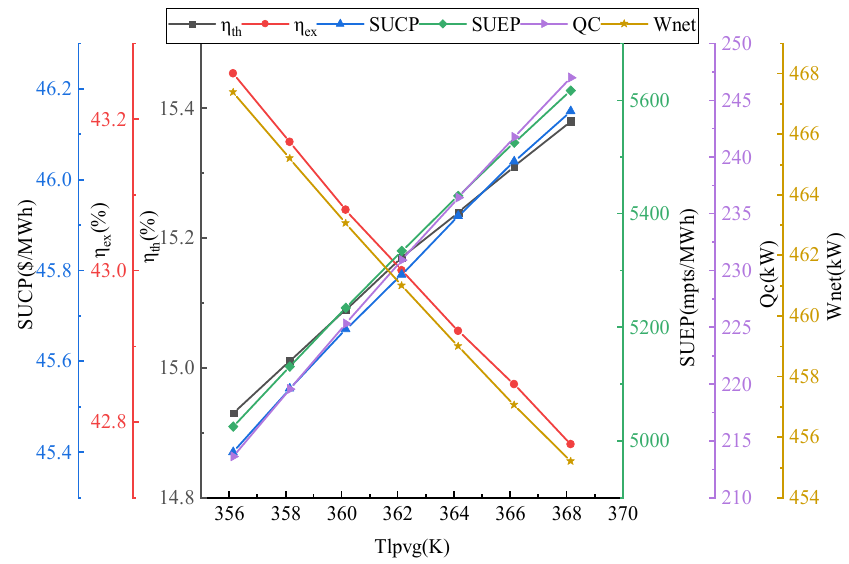
Figure 3. Effect of low pressure evaporation temperature on system performance.